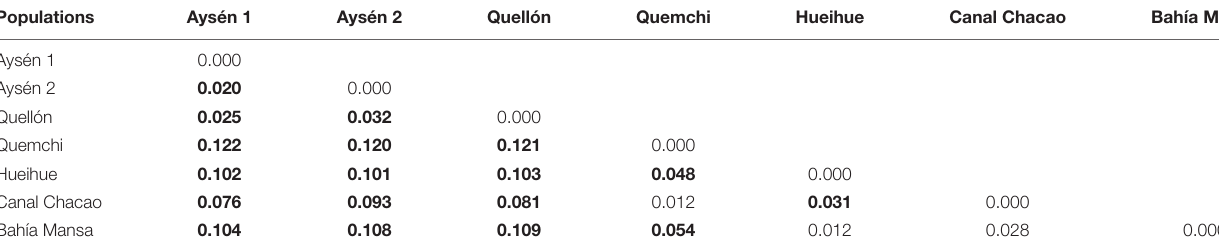
TABLE 3 | Pair-wise F ST parameters between populations (bold numbers = p <